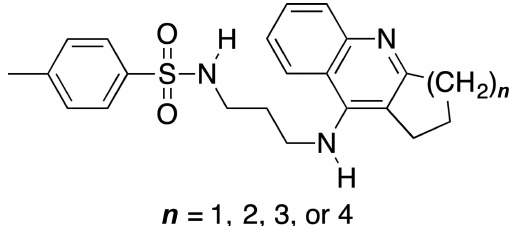
Figure 1 Acetylcholinesterase (AChE) and butyrylcholinesterase (BChE) inhibi- tors containing the N -propyl-4-methylbenzenesulfonamide moiety.